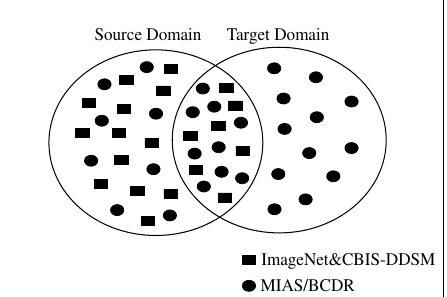
Figure 4. Sketching the instances transferring in double-shot transfer learning (DSTL), where some instances from the D t (MIAS or BCDR) are included in the D s (ImageNet and CBIS-DDSM). Note that SSTL has made the CBIS-DDSM instances part of the D s